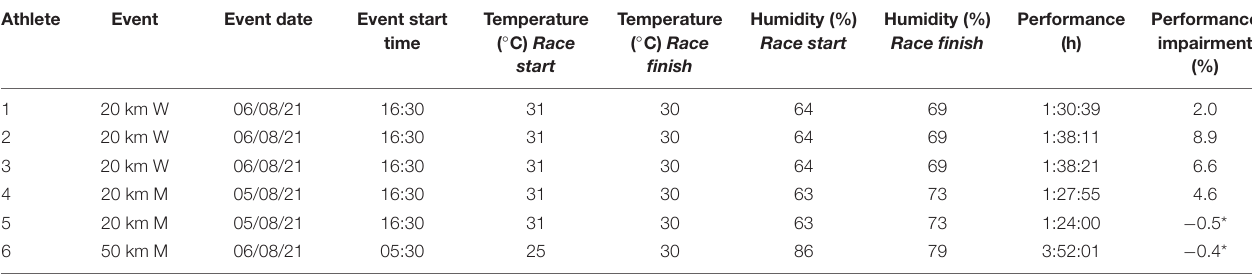
Performance times presented for men’s (M) and women’s (W) 20 and 50 km events. Performance impairments calculated as the percentage difference from personal best times prior to the Olympic Games. *Athlete 5 achieved a personal best time during the Olympic Games men’s 20 km event, and athlete 6 achieved a personal best performance during the 50 km